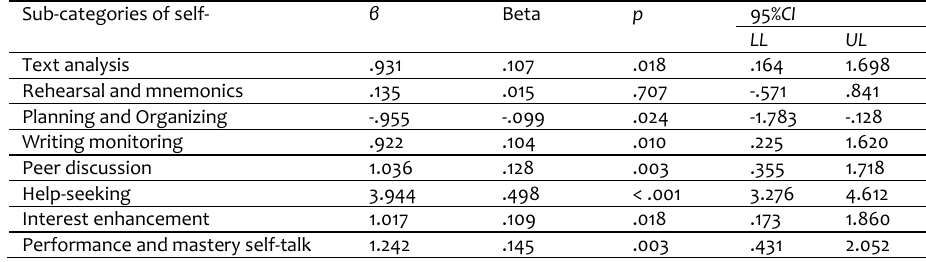
Table 6. Multiple Regression Results of the Eight Self-regulatory Strategies on Writing Test Scores (N =